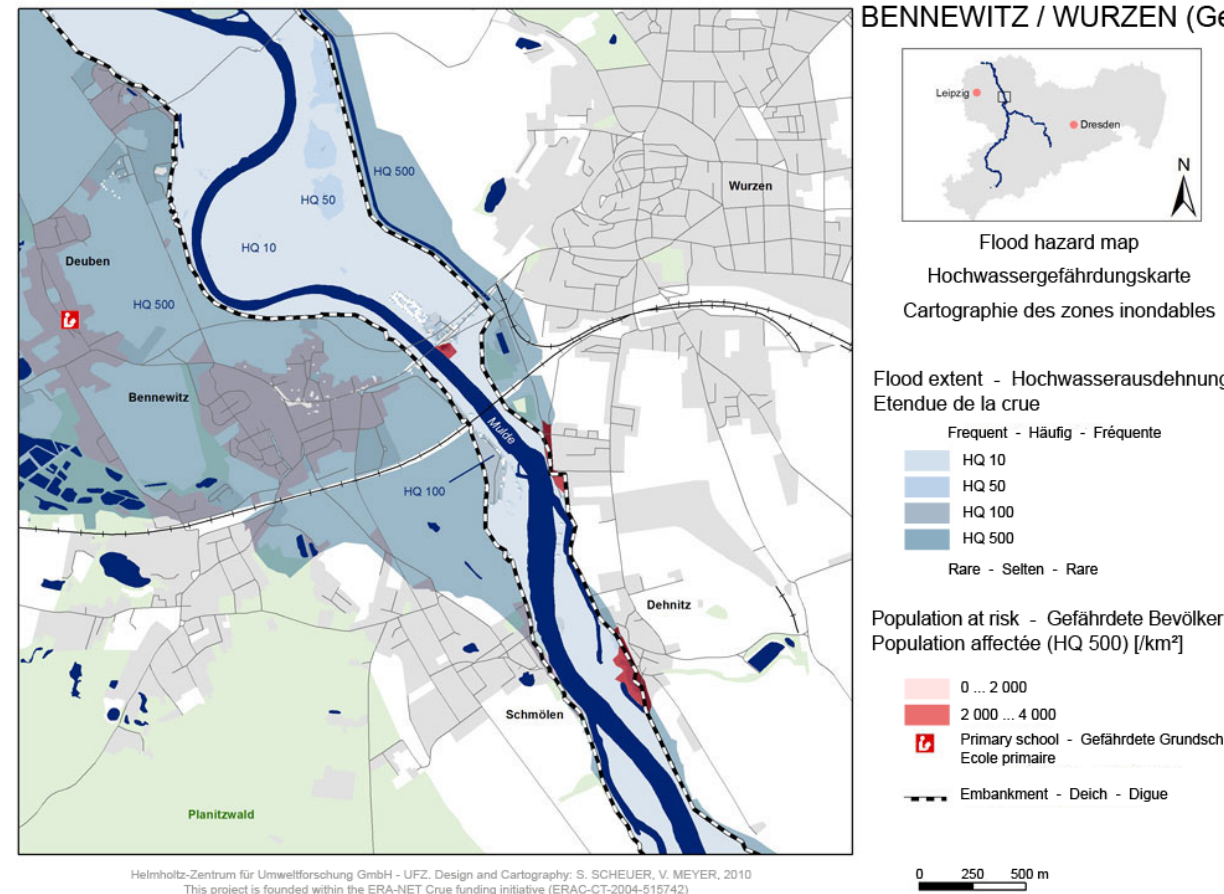
Fig. 1. Example for a test map for the eye-tracking-tests (case study Saxony): map contents include flood extent and population at Figure 1: Example for a test map for the eye-tracking-tests (case study Saxony): Map contents include flood extent and population at risk.